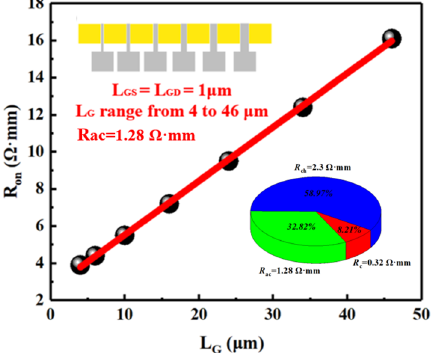
Figure 7. Evolution of R ON with L G and contribution of the resistance of each part to R ON of UTB − Al- GaN/GaN heterostructure with PEALD − AlN/PECVD − SiN x passivation.